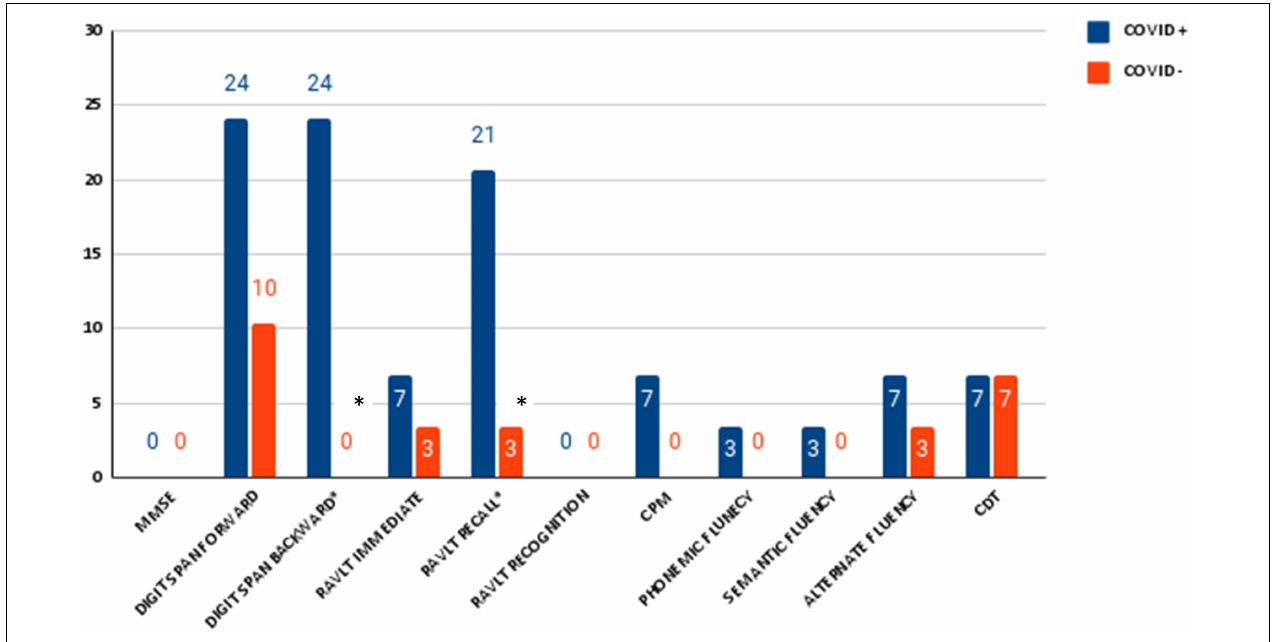
FIGURE 1 | Percentage of number of pathological neuropsychological test in patients with SARS-CoV-2 and control group. Significance is indicated with ∗